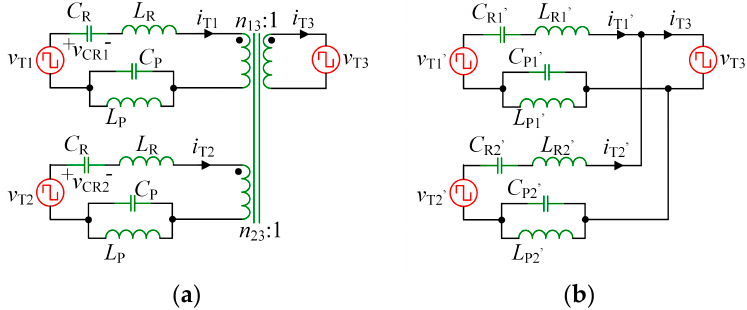
Figure 5. Equivalent circuits for analysis: ( a ) equivalent circuit of proposed isolated MR-TP-BDC; ( b ) transformer equivalent